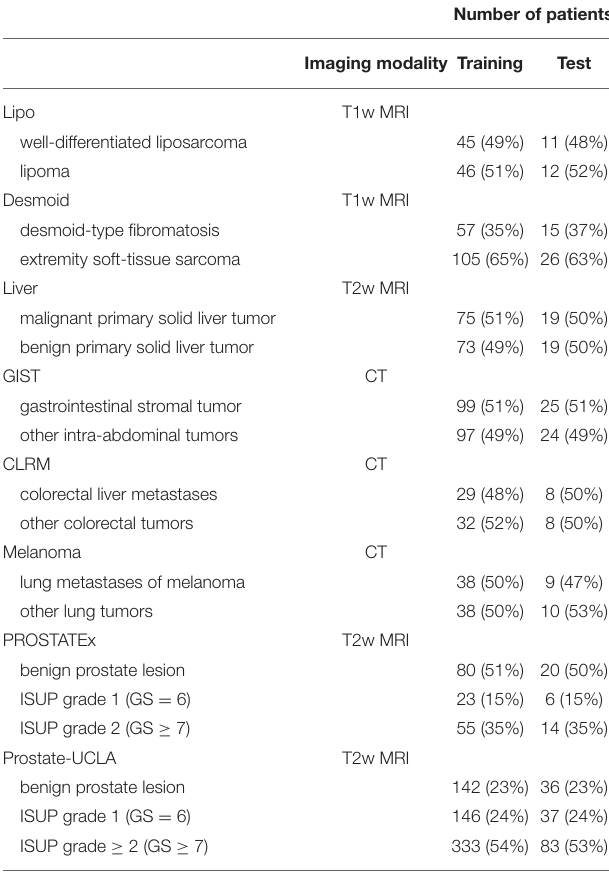
TABLE 1 | Characteristics of training and test